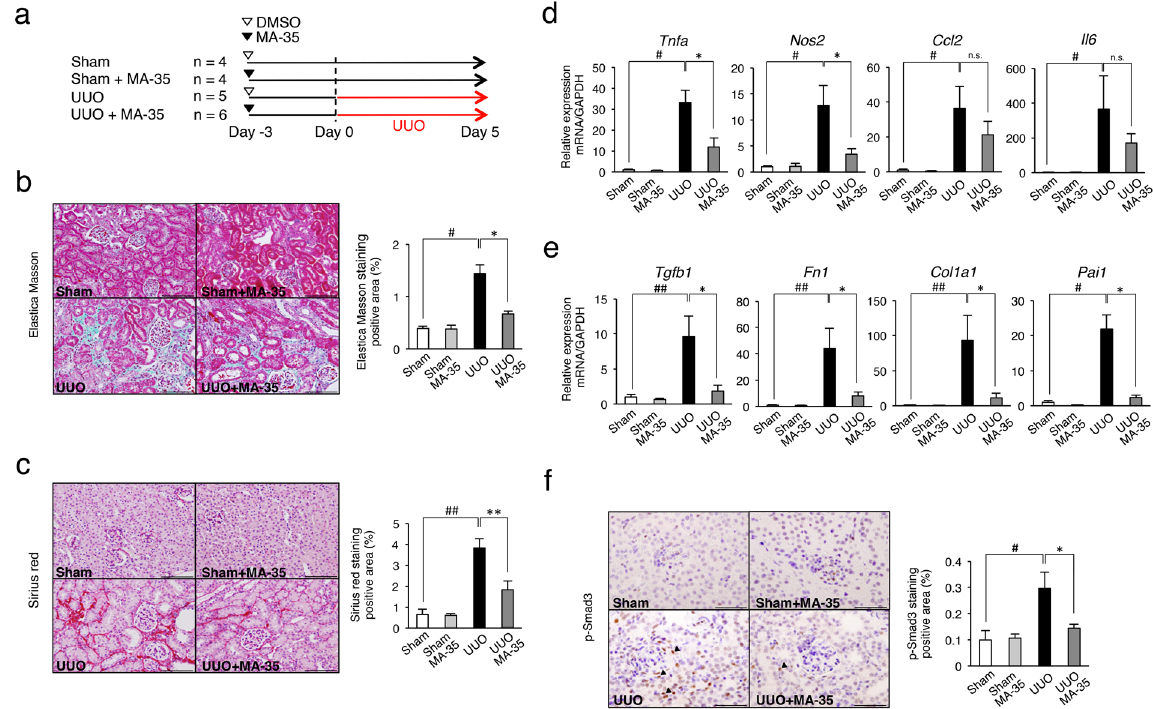
Figure 5. Effect of MA-35 on the renal inflammatory response and fibrosis in the UUO kidney in mice. ( a ) Experimental design. MA-35 or DMSO was administrated intraperitoneally starting from 3 day before UUO until sacrifice 5 days after UUO. Control mice groups received a sham-operation. Representative histological images of ( b ) Elastica Masson and ( c ) Sirius red staining in the kidney. Scale bars, 50 μ m. The graph shows the percentage of Elastica Masson-positive and Sirius red-positive areas relative to the whole area. Renal mRNA levels of ( d ) Tnfa , Nos2 , Ccl2 , Il6 , ( e ) Tgfb 1 , Fn1 , Col1a1 and Pai-1 were measured by real-time PCR. ( f ) Representative histological images of p-Smad3 staining in the kidney. Black arrowheads indicate p-Smad3- positive cells. Scale bars, 50 μ m. The graph shows the percentage of p-Smad3-positive areas relative to the whole area. # p < 0.05, ## p < 0.01 v.s. Sham, * p < 0.05, ** p < 0.01 v.s.